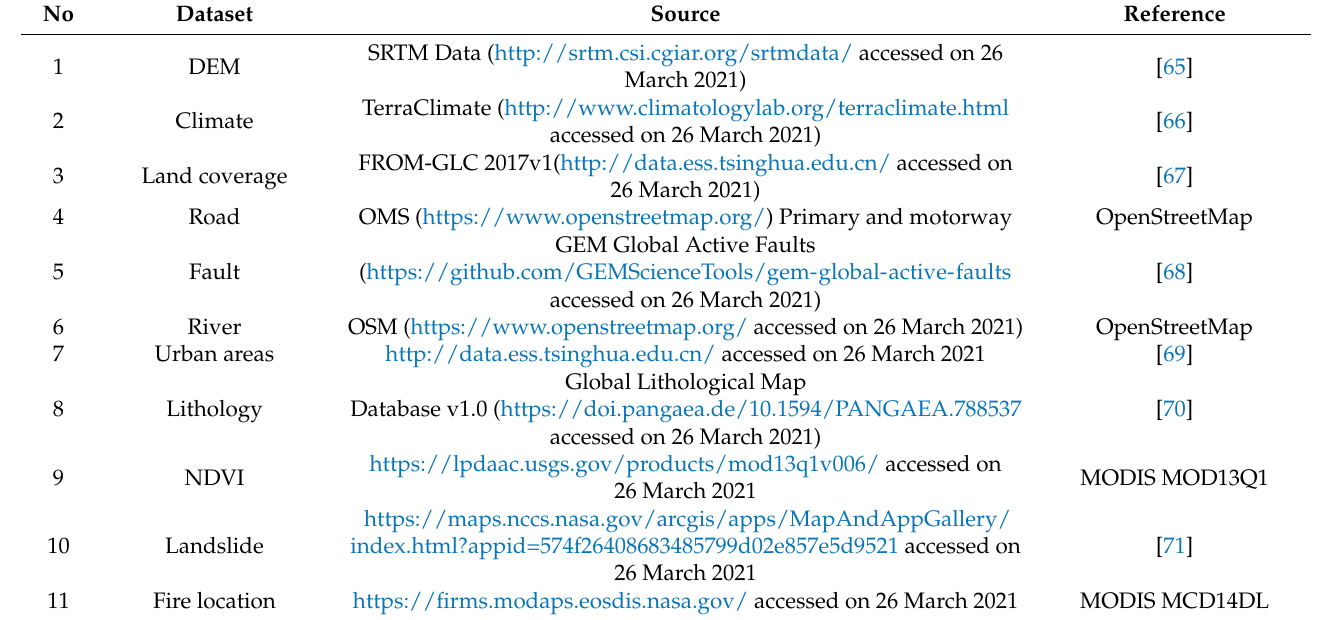
Table 1. Summary of the data sources used in this